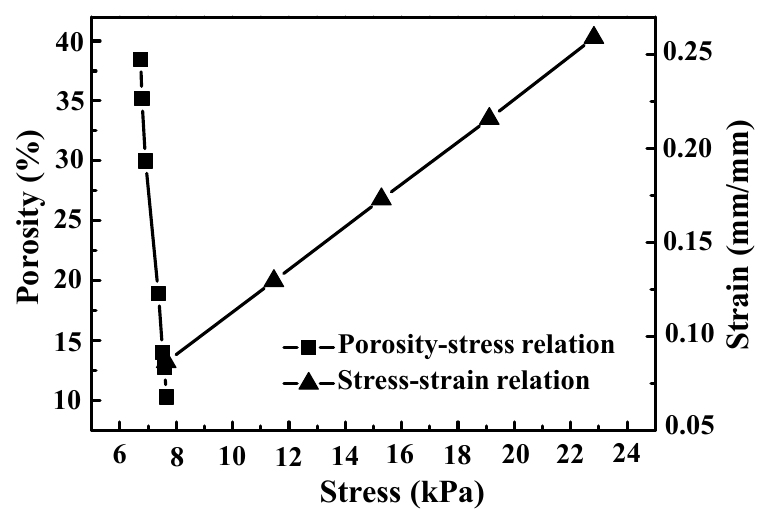
Figure 6. Regression model between the porosity of the fabrics, the strain, and the stress of the human body.